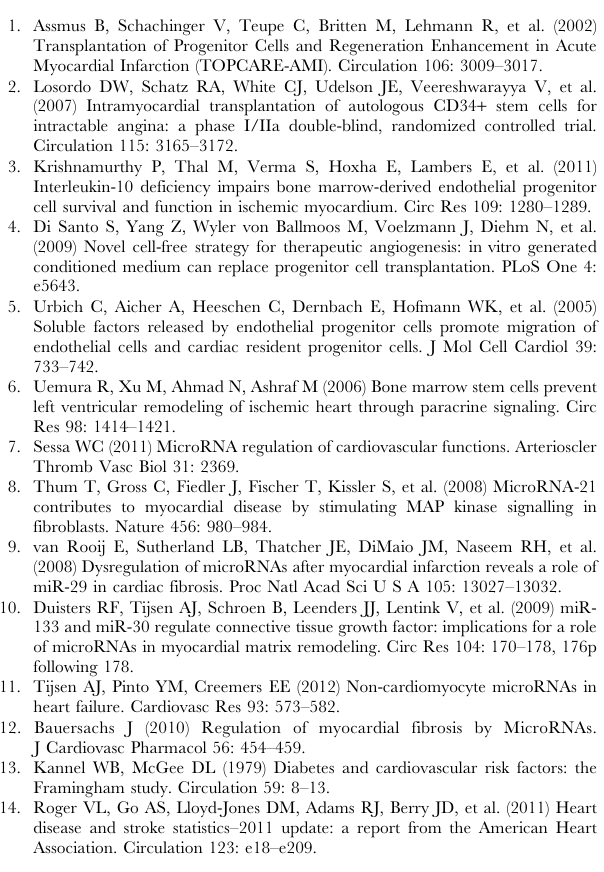
Figure S1 Secreted HGF levels. ELISA for HGF secreted by BMPCs after 48 hrs in growth-free EBM-2 media. Secretion from SVEC in similar media was used for comparison. Figure S2 miR-155 over-expression in adult mouse cardiac fibroblasts. miR-155 expression (determined by qRT-PCR) was increased in cardiac fibroblasts transfected with miR-155 mimics (pre-miR-155) for 72 h as compared to cells transfected with negative control mimics (control). *P , 0.01 compared with control-transfected cardiac fibroblasts. Figure S3 ELISA for HGF levels secreted from BMPCs transfected with HGF siRNA. HGF secretion was reduced in BMPCs 48 hours after transfection with siRNA directed against HGF. P , 0.01 versus control siRNA transfected cells.